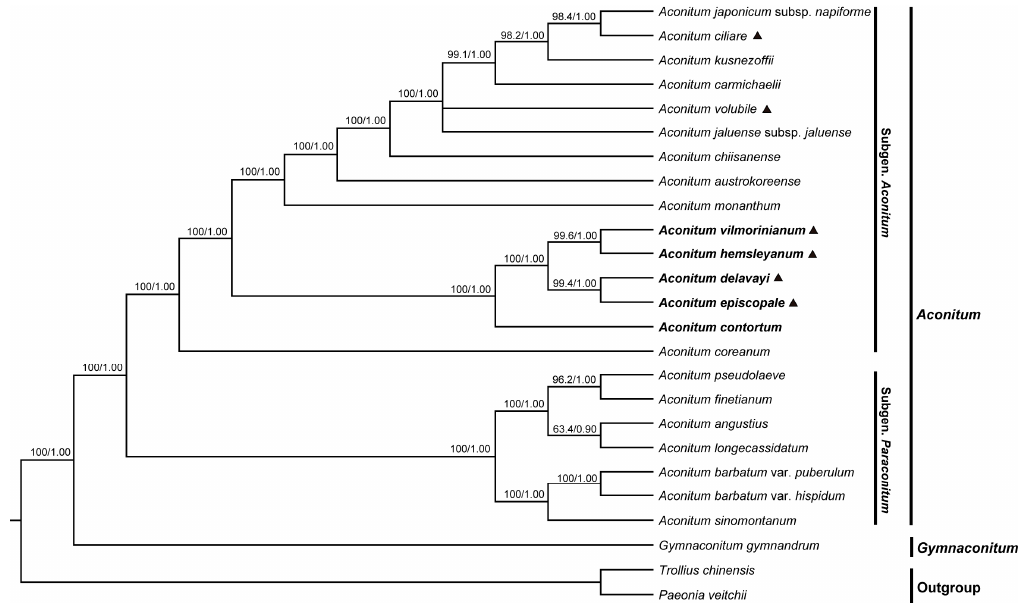
Figure 8. Phylogenetic tree constructed using Maximum Likelihood (ML) and Bayesian Inference (BI) methods, based on the whole cp genomes from different species. The numbers above the branches represent ML bootstrap values/BI posterior probabilities. Triangle: twining species belonging to subgen. Aconitum.